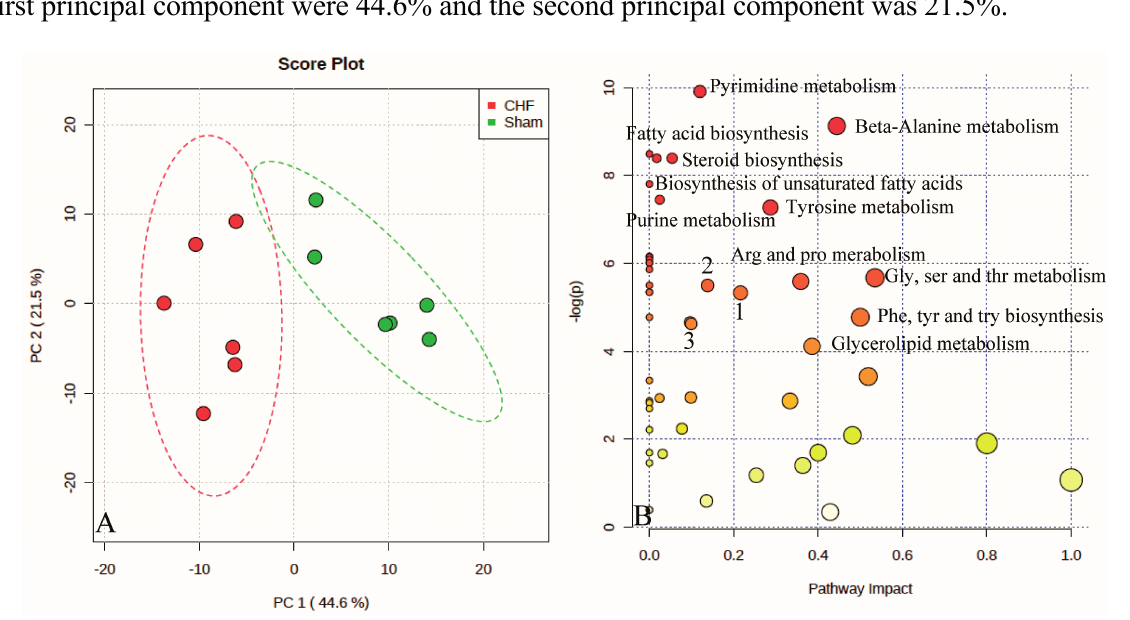
Figure 1. Score plots for principle component analysis model of rat urine data in the CHF and Sham surgery groups ( A ) Red dots, CHF group; Green dots, Sham surgery group; Metabolomic pathway analysis overview ( B ) indicating selected metabolic pathways that are significantly affected between CHF and sham surgery group. Size of the node indicates the pathway impact (based on the impact of each identified metabolite in a given pathway). The node color is graded depending on its p -value from pathway enrichment